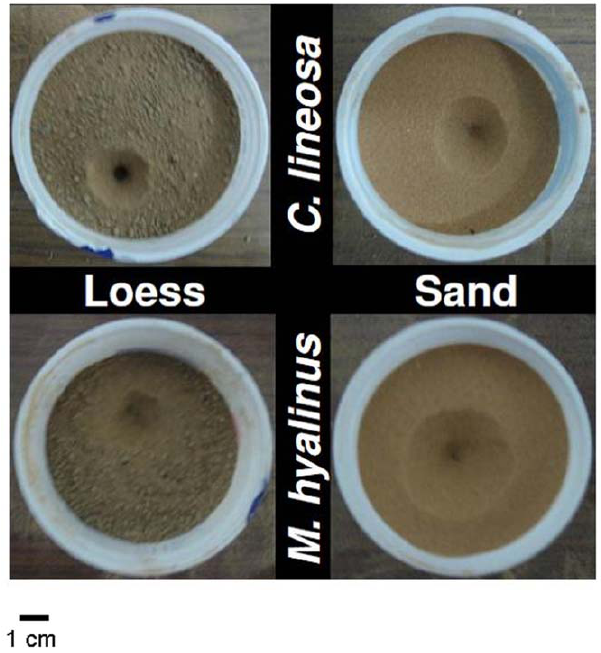
Figure 1. Experimental design showing pit construction of both antlion species in the two soil